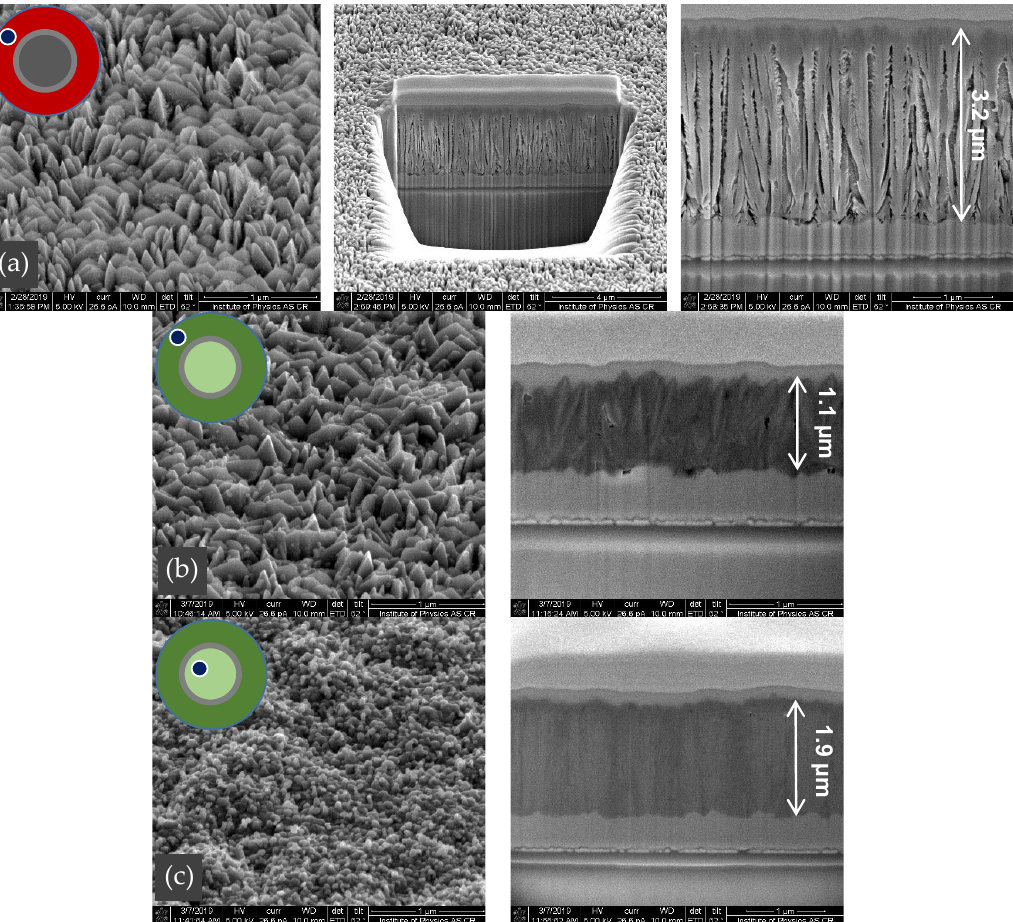
Figure 7. SEM images and corresponding vertical cross sections created by the focused ion beam. ( a ) Hematite Fe 2 O 3 film before sulfidation, ( b ) marcasite α-FeS 2 after sulfidation and ( c ) pyrite β-FeS 2 after sulfidation. Deposited on FTO glass in DC mode, with the following parameters: discharge current 150 mA, pressure 4.7 Pa, distance from the nozzle 4 cm, argon flow rate 170 sccm, oxygen flow rate 1 sccm and deposition time 60 min ( a ) and 30 min ( b , c ). Absorption spectra of the deposited films were measured in the range from 200 to 900 nm, using a deuterium lamp and an HR4000CG-UV-NIR spectrometer (originally Ocean Optics, now Ocean Insight, USA) and are shown in Figure 8. The absorbance of the reference TiO 2 film starts to decrease at approximately 350 nm and up to 430 nm more than 90% of the radiation is absorbed. This edge is shifted up by approximately 50 nm for the hematite film deposited in the pulsed DC mode. A further shift up to 600 nm was observed for the red hematite region of the film deposited in the DC mode. This is significant improvement, since the solar radiation spectrum has a maximum at 500 to 600 nm. After sulfidation, the absorption of the marcasite film is extended to 800 nm. The magnetite and pyrite regions of the same films are almost nontransparent, and their absorbance is over the limits of the spectrometer used.